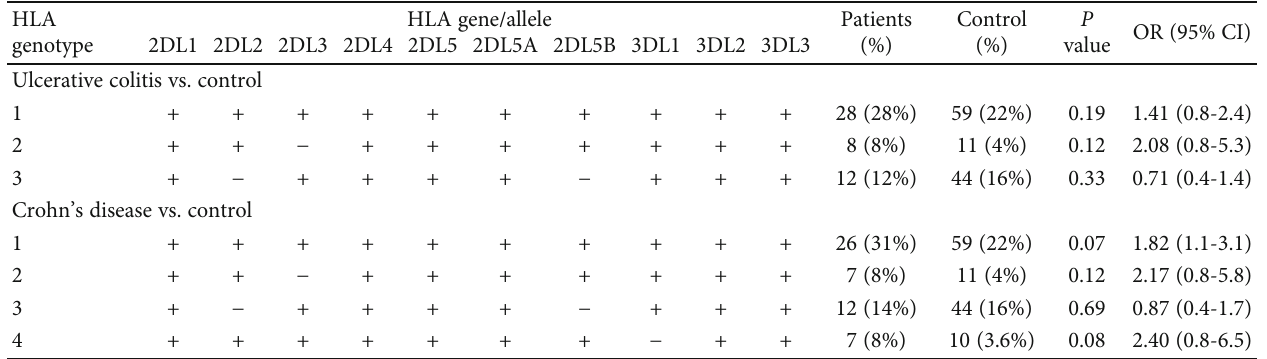
Supplementary fi le 1: the sequence of primer sets (speci fi c and internal) of the PCR-SSP assay for combined KIR-HLA genotyping. (Supplementary